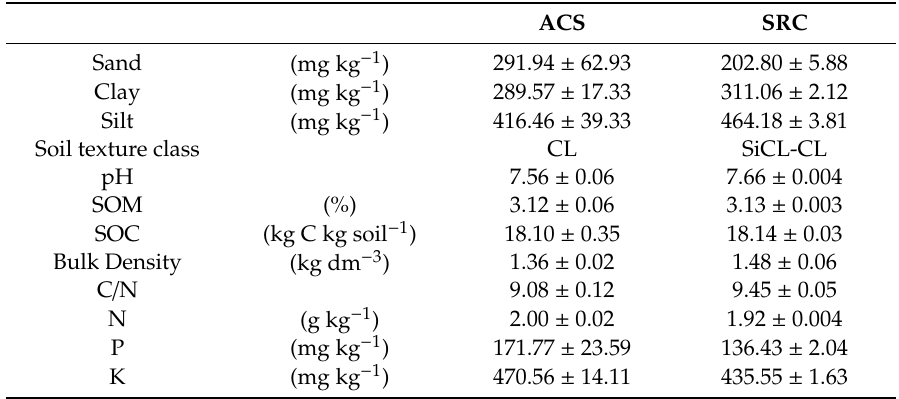
Table 1. Soil characteristics at a depth of 0–10 cm in the two systems, reported as